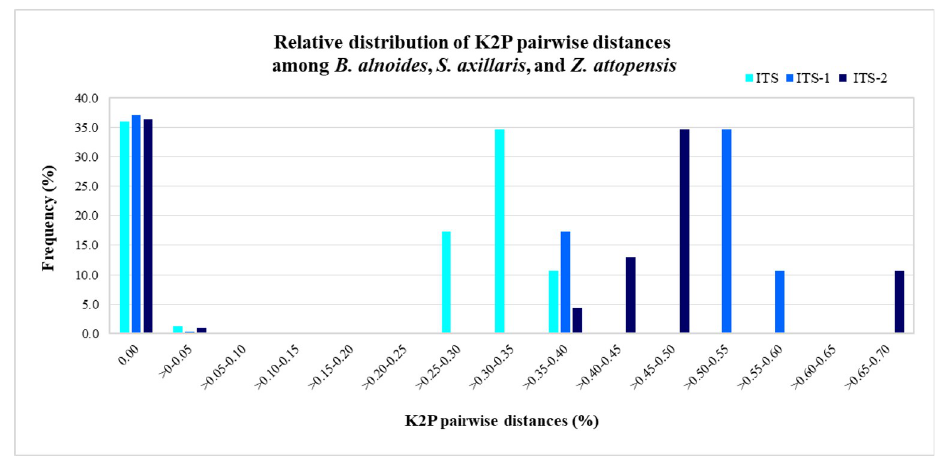
Fig 2. Relative distribution of the K2P pairwise distances of ITS, ITS1, and ITS2 among B . alnoides , S . axillaris , and Z . attopensis .